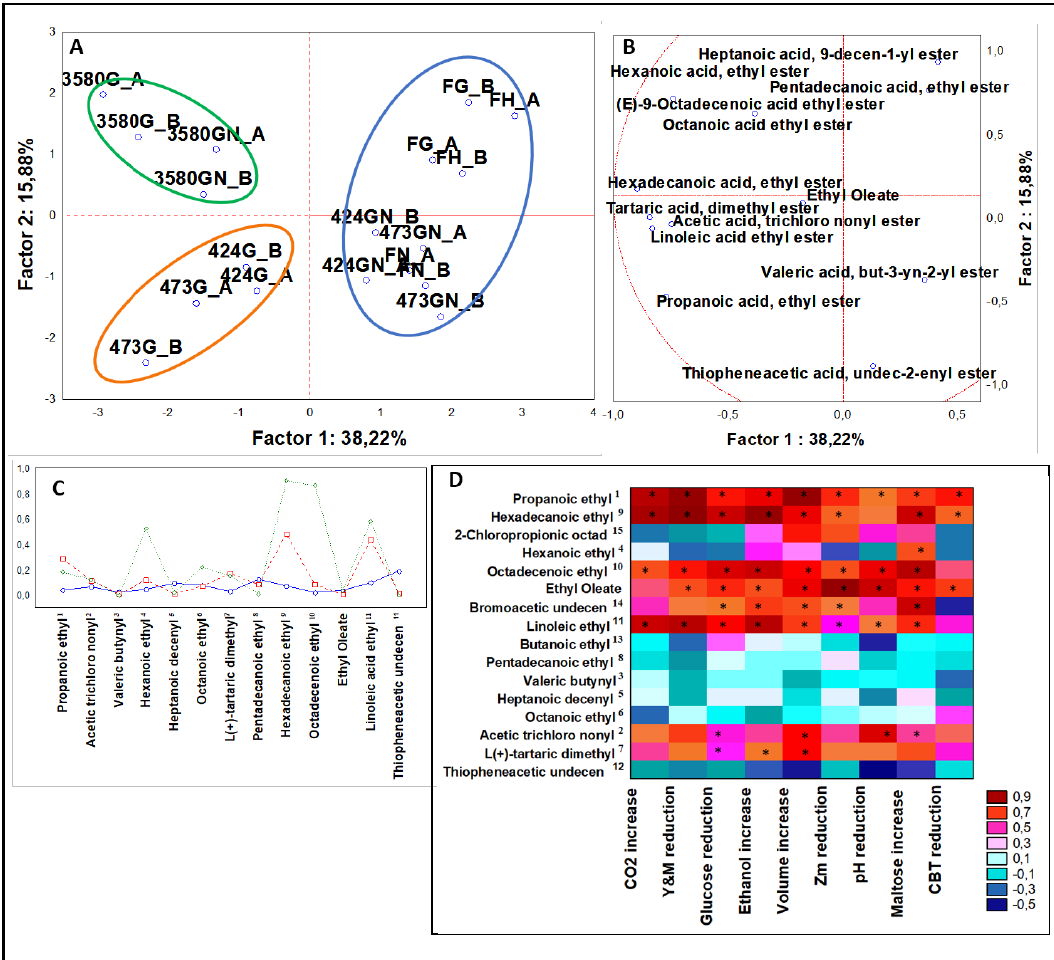
Figure 3. ( A ) PCA of cases and ( B ) variables on esters; ( C ) K-means clustering; ( D ) Spearman rank